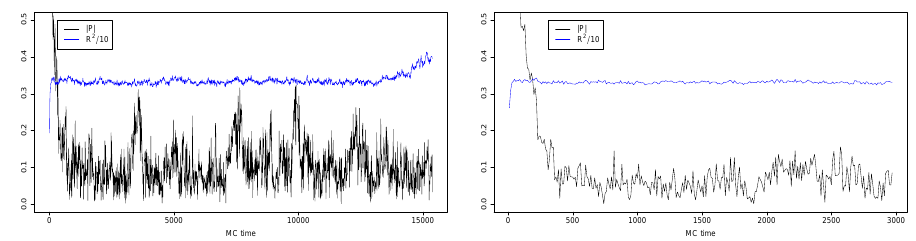
Figure 4. Monte Carlo histories from cold starts ( X 1 = X 2 = ··· = X 9 = 0) for BFSS, T = 0 . 2 , L = 48 , N = 10 (left) and N = 16 (right). For N = 10, the onset of the run-away behavior (i.e., the increase of R 2 / 10) can be seen at a late time. R 2 / 10 denotes the normalized sum of all (nine) scalars (cid:80) 9 R 2 = Tr X 2 . M = 1 M